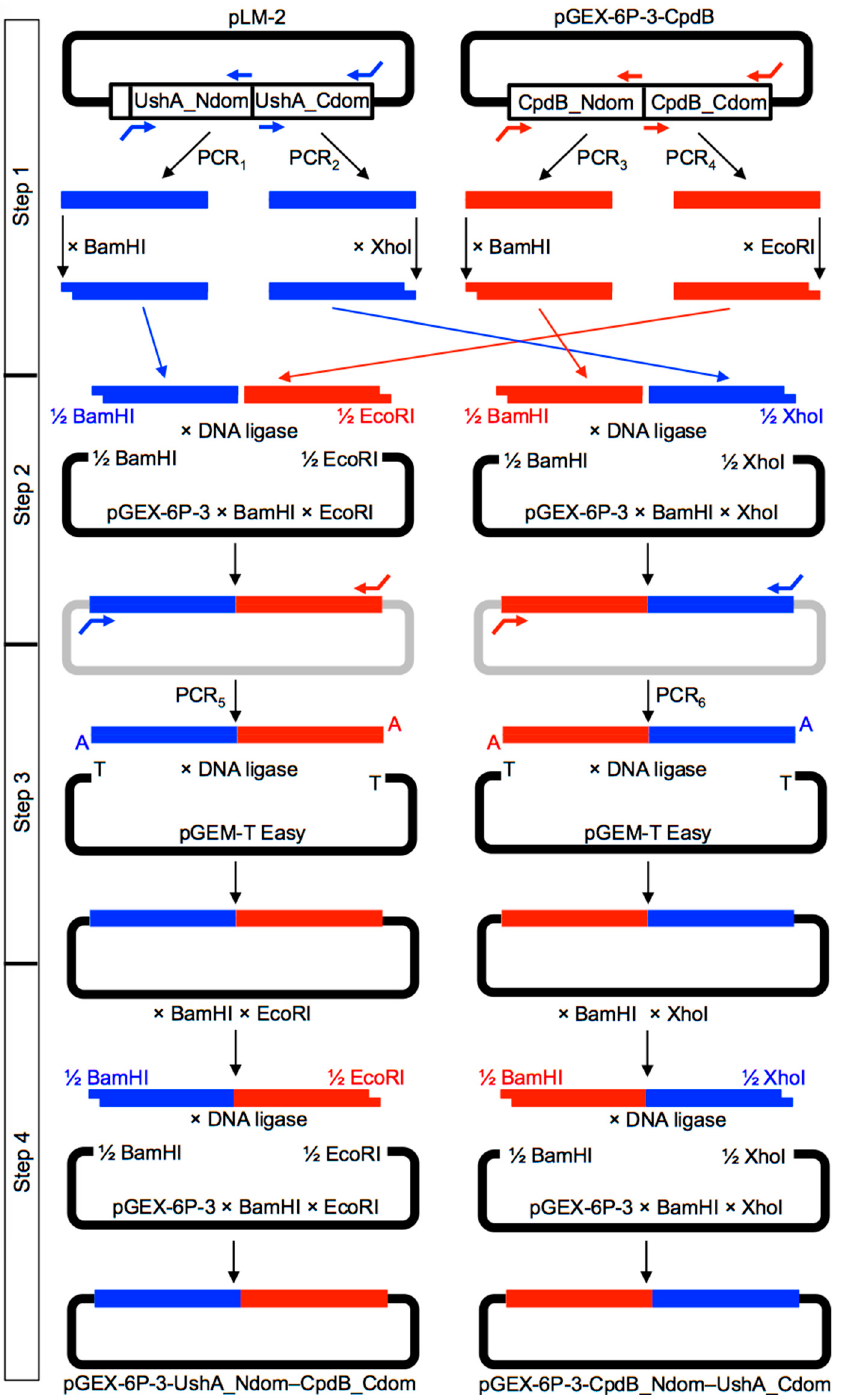
Figure 4. Strategy followed to construct DNA sequences encoding UshA_Ndom–CpdB_Cdom and